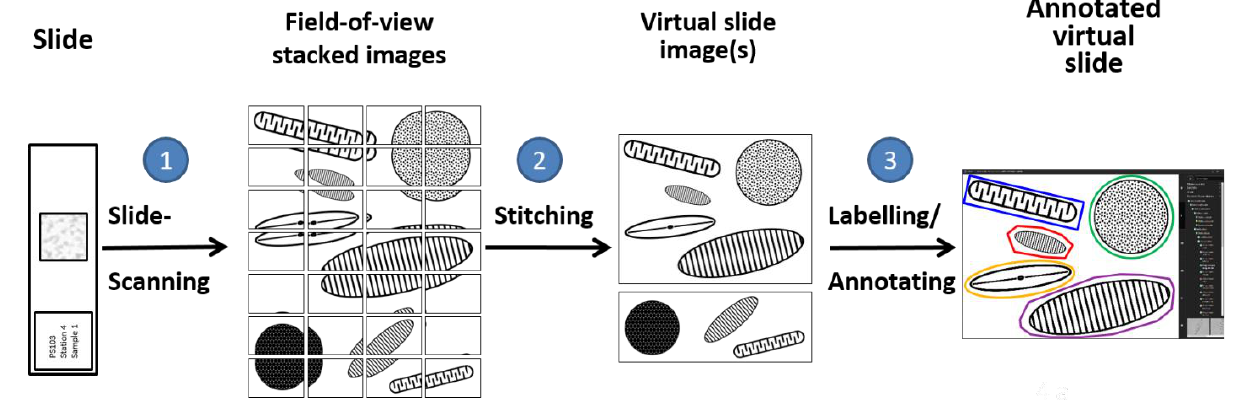
Figure 2. Construction of a virtual slide image. The slide is imaged by a slide scanning microscope, each field of view is captured at multiple focus depths that are then focus-stacked in an intermediate step (1). The focus-stacked, slightly overlapping field of view images are joined via a stitching procedure into a single, large image file encompassing the whole scanned slide area at full original resolution (2). The virtual slide images are uploaded to the BIIGLE 2.0 image annotation platform and diatoms are identified and labelled manually through a web browser, detail in Figure 3a (3). Image modified from Kloster et al. 2020 [33].